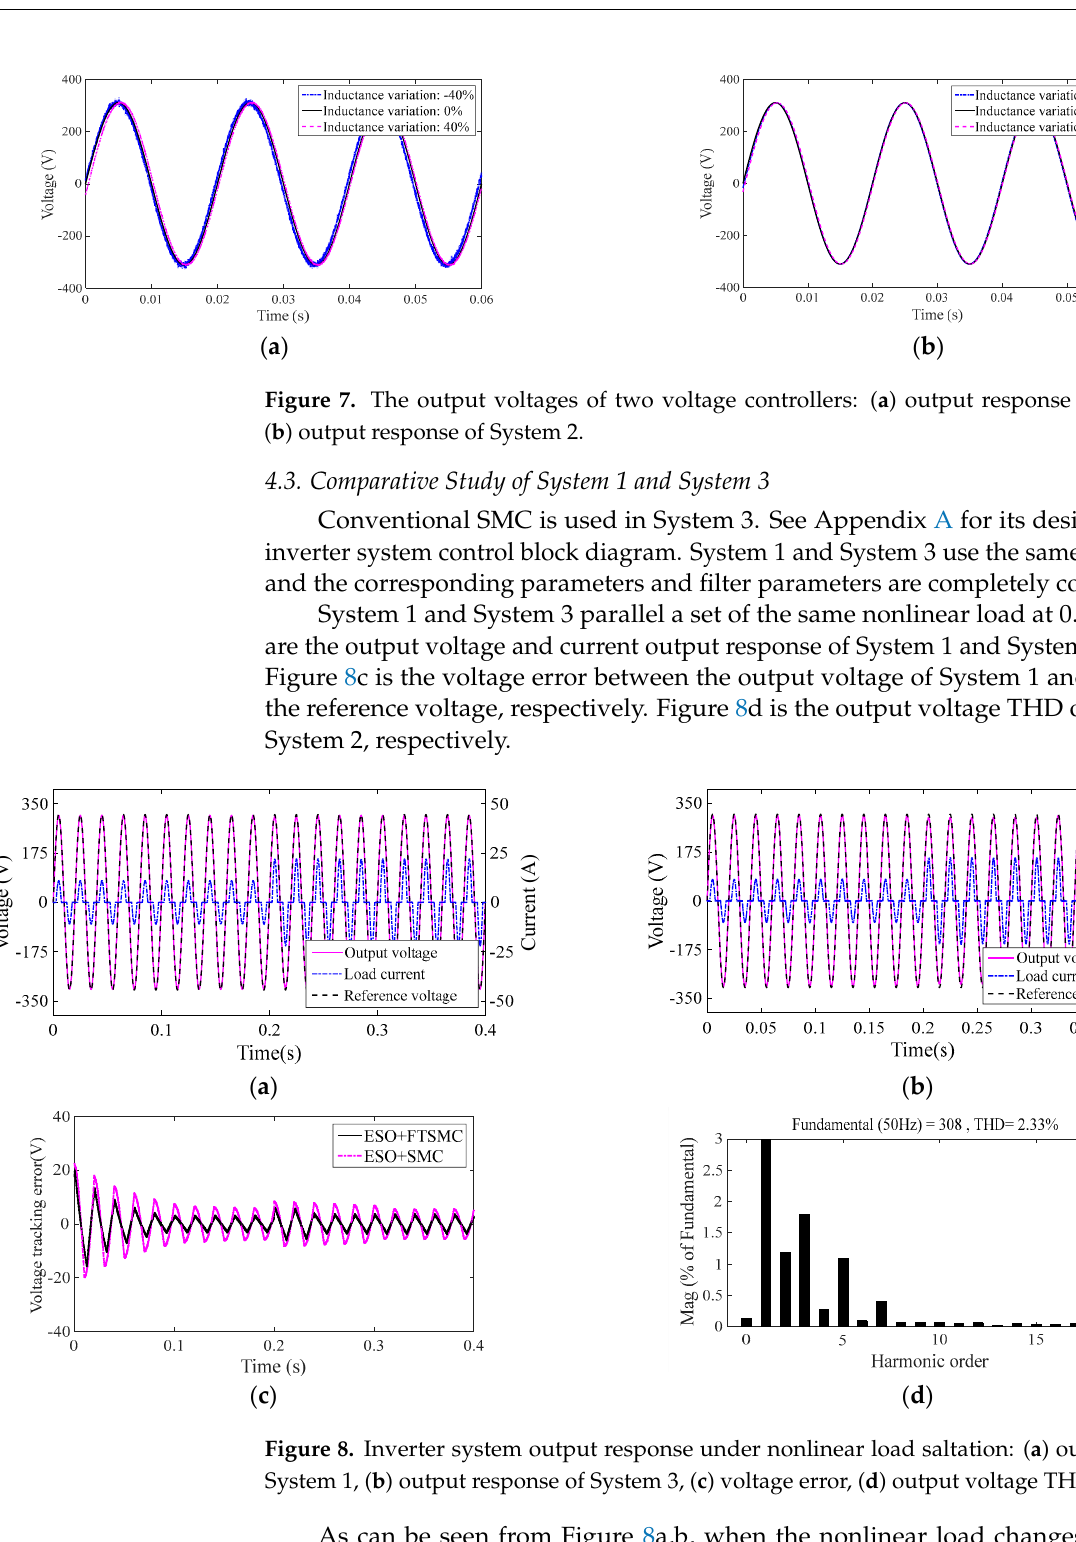
Figure 8. Inverter system output response under nonlinear load saltation: ( a ) output response of System 1, ( b ) output response of System 3, ( c ) voltage error, ( d ) output voltage THD of System 1.